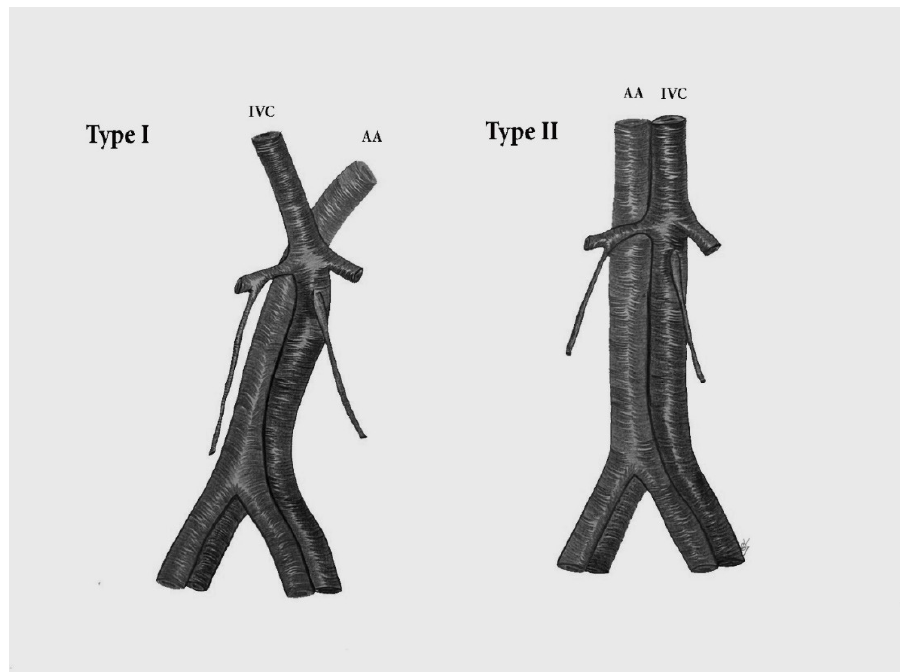
Figure 16. Left sided inferior vena cava. Type I—the IVC passes anterior to the level of the LRV to form a normal right-sided IVC. Type II—the IVC does not cross the aorta and continues its passage upward. The left sided IVC is a mirror image of normal anatomy—the right ovarian vein drains into the RRV and the left ovarian vein drains into the IVC. IVC—inferior vena cava, AA—abdominal aorta.